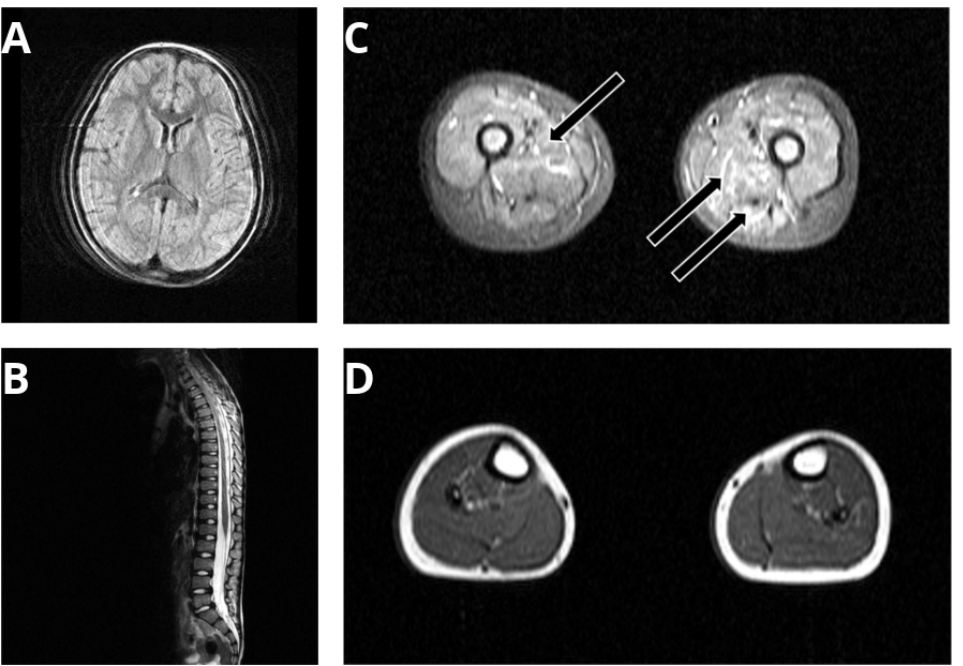
Figure 1. Clinical findings in the p.(A20S)-SPTLC1-patient: MRI of brain ( A ) and spinal cord ( B ) revealed normal findings. Edematous alterations in musculus vastus medius, lateralis, and intermedius (black arrows in C ). No fatty degenerations were detected, and MRI of lower legs revealed no pathological alterations ( D ). The limited quality of the MRI images is based on motion artifacts of the child during the investigation.